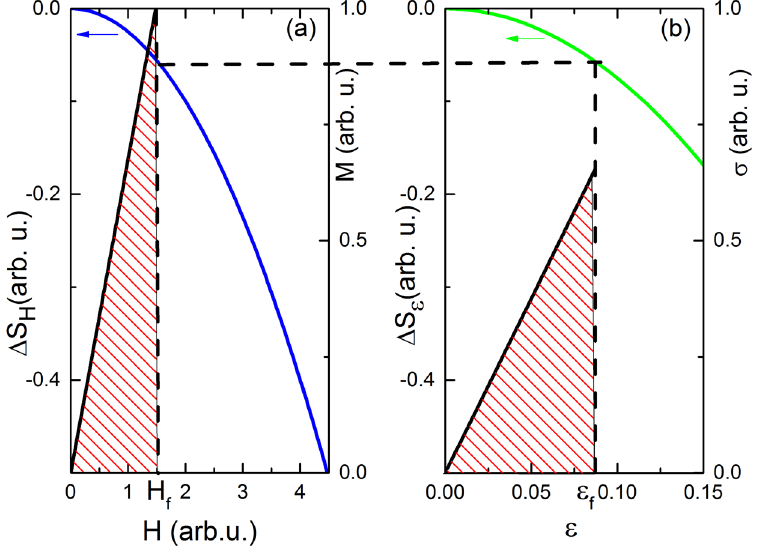
Figure 1. Thermodynamic Approach. ( a ) Blue curve depicts the isothermal entropy change ∆ s (left axis). H Black line shows the magnetization M as a function of H (right axis). The dashed area resembles the magnetic work when exposing the sample to the magnetic field H . ( b ) Green curve depicts the isothermal entropy change f ∆ s (left axis). Black line shows stress σ as a function of  (right axis). The dashed area resembles the elastic work  when straining the sample to and ∆ s  . The horizontal dashed line indicates equal values of ∆ s f H f f 